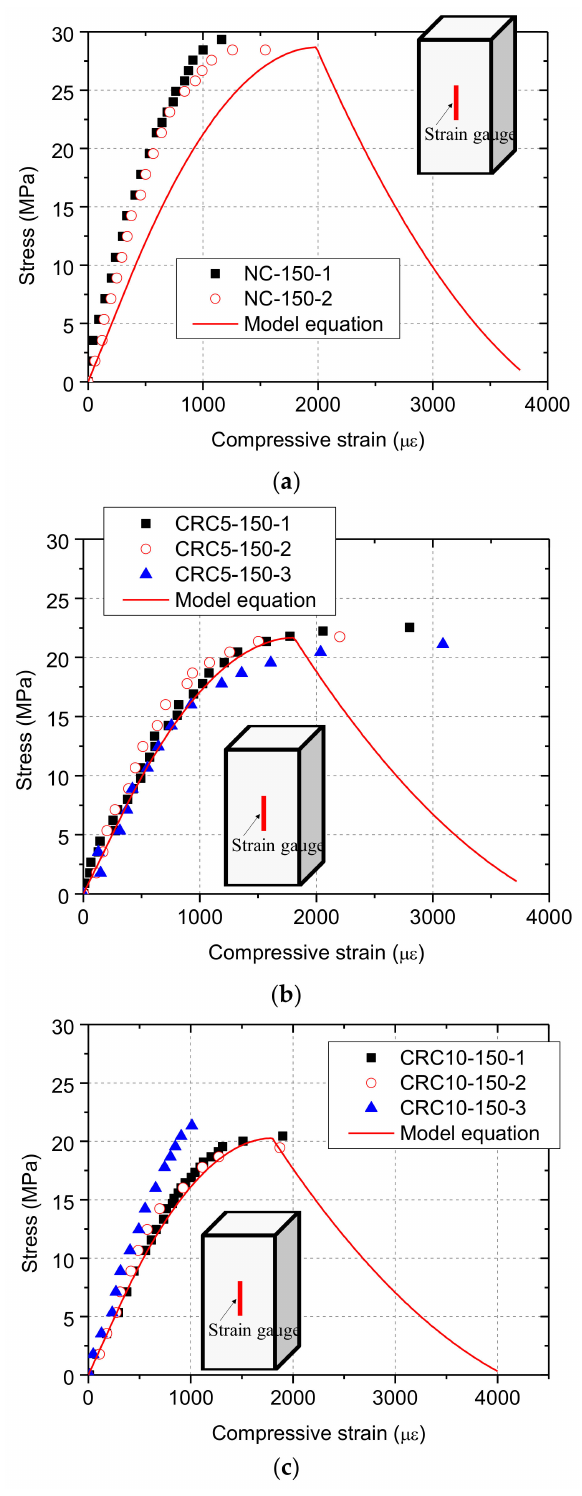
Figure 6. Compressive stress–strain curves of specimens under full contact loading: ( a ) normal concrete (NC)-150; ( b ) crumb rubber concrete (CRC)5-150; ( c )